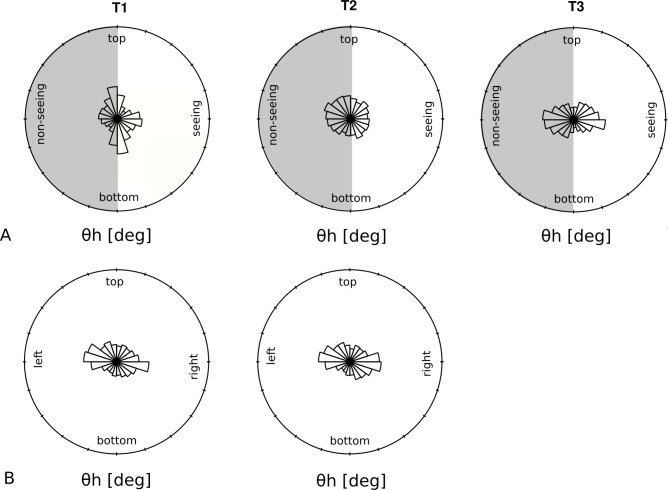
Directional characteristics of the eye movement pattern.The distribution of the wedges shows the angles theta (θh) between the saccades and the horizontal meridian. A: Changes in eye movement patterns during VS for one patient with major improvement in STs (only 6 months after onset of HH). Before training, the patient showed many vertical saccades, while horizontal saccades were mostly directed towards the seeing hemifield (white). At T2, the dominance of vertical saccades has disappeared, and more horizontal saccades are directed towards the non-seeing hemifield (gray). At T3, a prevalence of horizontal saccades has developed, so that the search pattern now resembles the pattern of the healthy subjects. B: Search patterns of one healthy subject at T1 and T2. The length of each radial wedge indicates the number of saccades in that direction without change just by repeating the task.